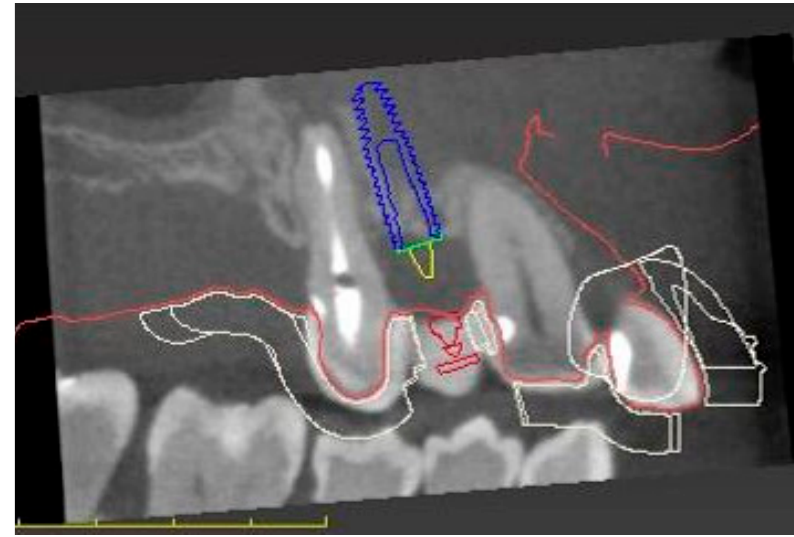
Figure 3. Digital planning of the implant and surgical template position.